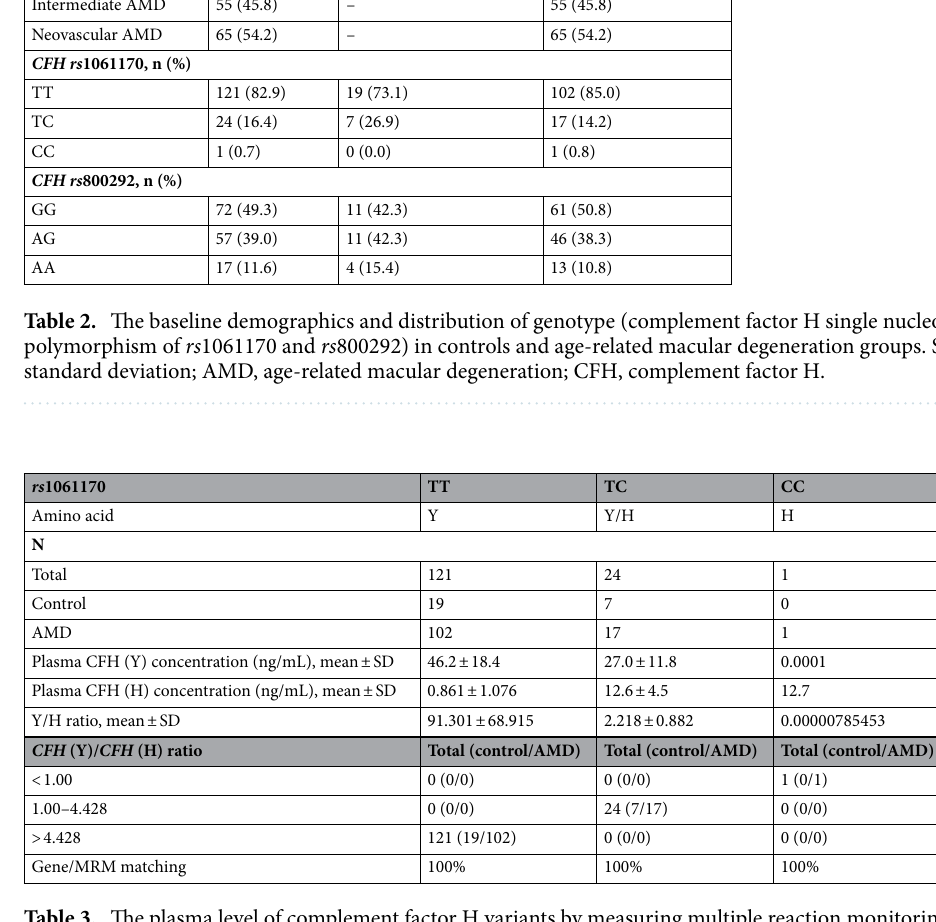
Table 3. The plasma level of complement factor H variants by measuring multiple reaction monitoring assay and distribution, matching according to the genotype of complement factor H single nucleotide polymorphism rs 1061170. Y, tyrosine; H, histidine; AMD, age-related macular degeneration; MRM, multiple reaction monitoring; SD, standard deviation.